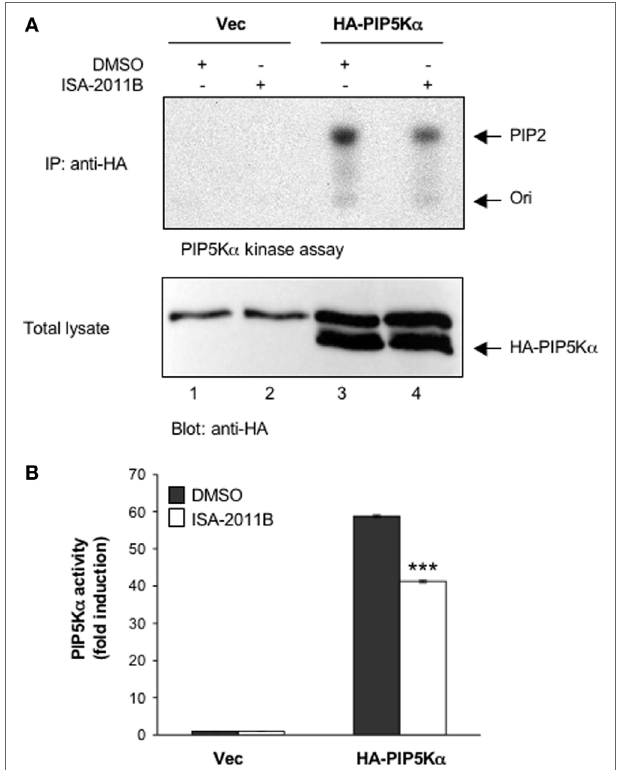
FigUre 2 | isa-2011B inhibits exogenously expressed PiP5K α lipid-kinase activity . (a) Jurkat cells were transfected and cultured for 24 h with 20 µg control empty vector (Vec) or 20 µg HA-PIP5K α and then treated for further 6 h with DMSO or 25 µM ISA-2011B. PIP5K α kinase assays performed on anti-HA IP (upper panel). HA-PIP5K α content was analyzed by western blotting (lower panel). (B) Fold inductions were quantified by densitometric analysis and normalized to HA-PIP5K α levels. Data are expressed as fold induction over the basal level of cells transfected with empty vector and treated with DMSO. Bars show the mean ± SD of two experiments. Asterisks (***) indicate P < 0.001 calculated by Student’s t -test, compared with cells transfected with HA-PIP5K α and treated with DMSO.